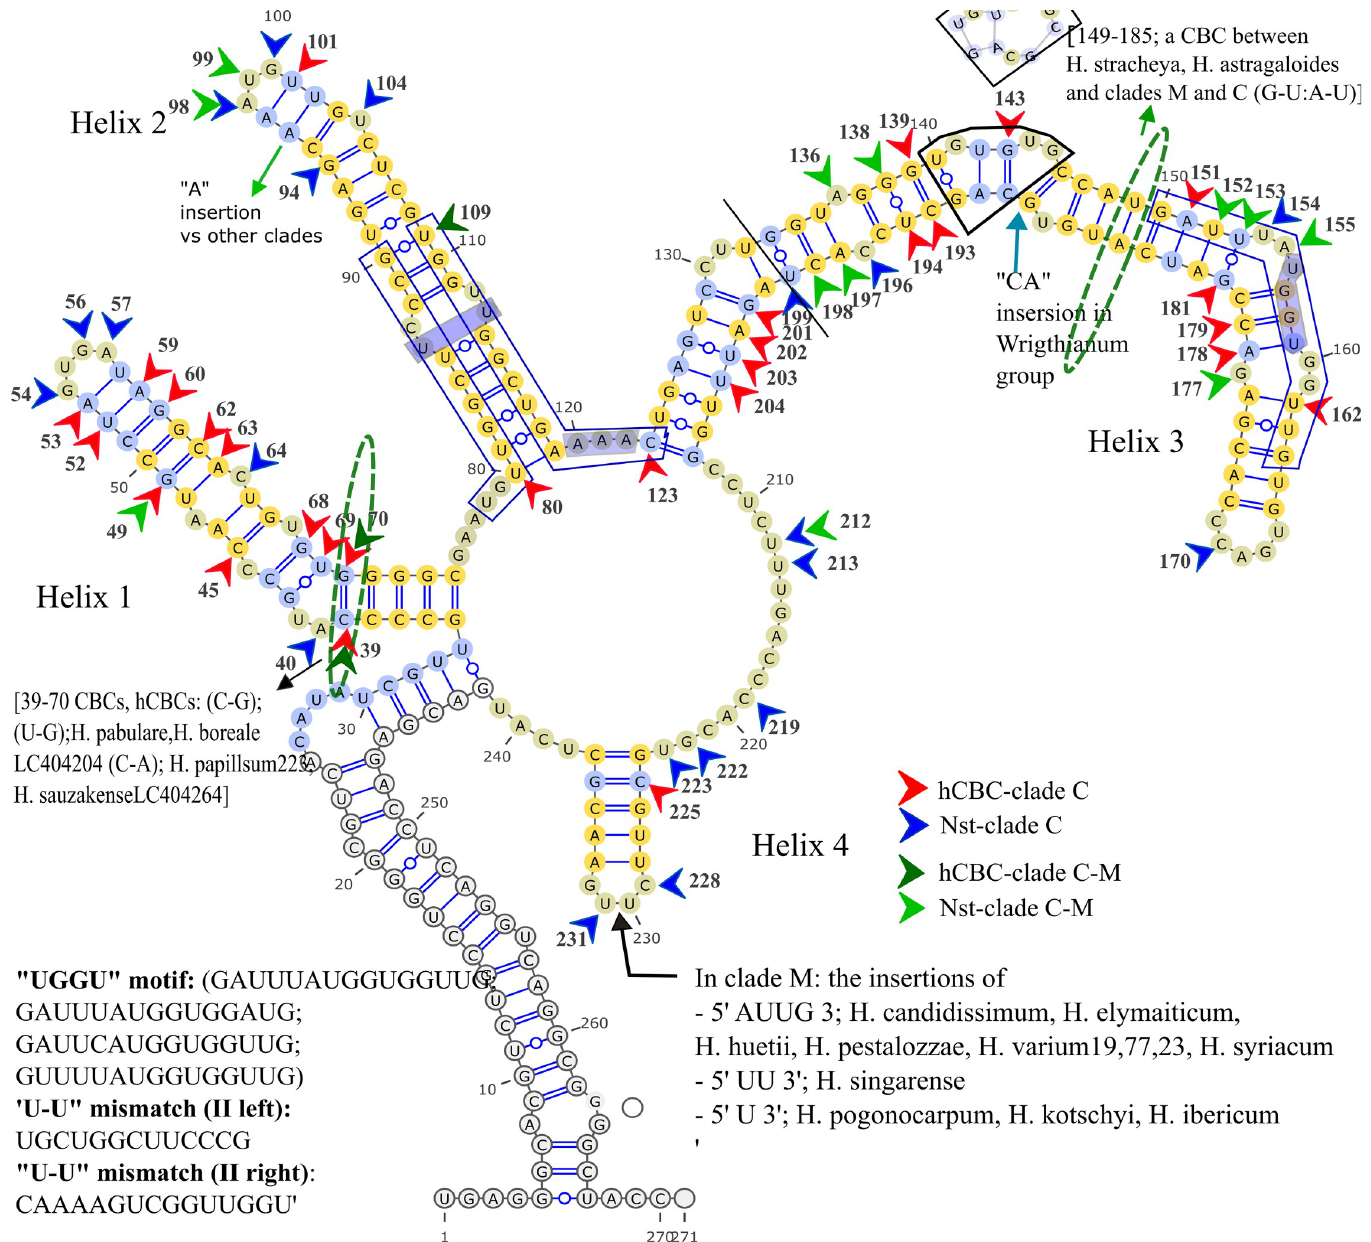
Fig 8. ITS2 Consensus secondary structure of H . sect. Multicaulia Subsect. Crinifera (clade C). Yellow flashes 100% conserved regions in the section. structures. H . damghanicum Rech.f. separate from the group (B) members with three hCBCs in Helix and plus two Nsts in Helix of ITS2. While, H . sauzakense Rech.f. group (C) versus the H . kopetdaghi Boriss. group (D) didn’t specify any informative changes in the structure of the ITS1, signified with two Nsts located in Helix of ITS2. Indeed, between two groups in ITS1 dataset, there is an informative nucleotide site (149 of aligned, G > C) but a rearrangement of nucleotides at the tip of Helix 4 made any sense of CBC or hCBC. On the other hand, H . bojnordense shared the same set of nucleotides